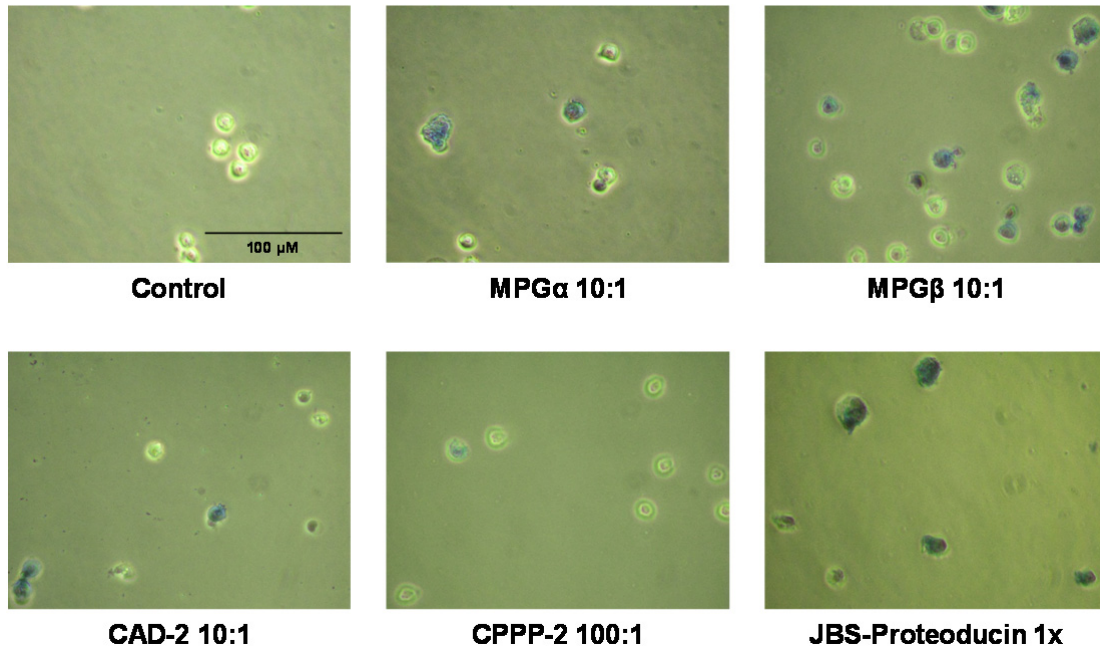
Figure 4. Internalization of β -galactosidase into Jurkat cells using different CPPs. Complexes of β -galactosidase with CPPs formed in the indicated ratios were internalized into Jurkat cells. After staining with X-gal the number of stained cells and the intensity of the staining indicate the efficiencies of the respective